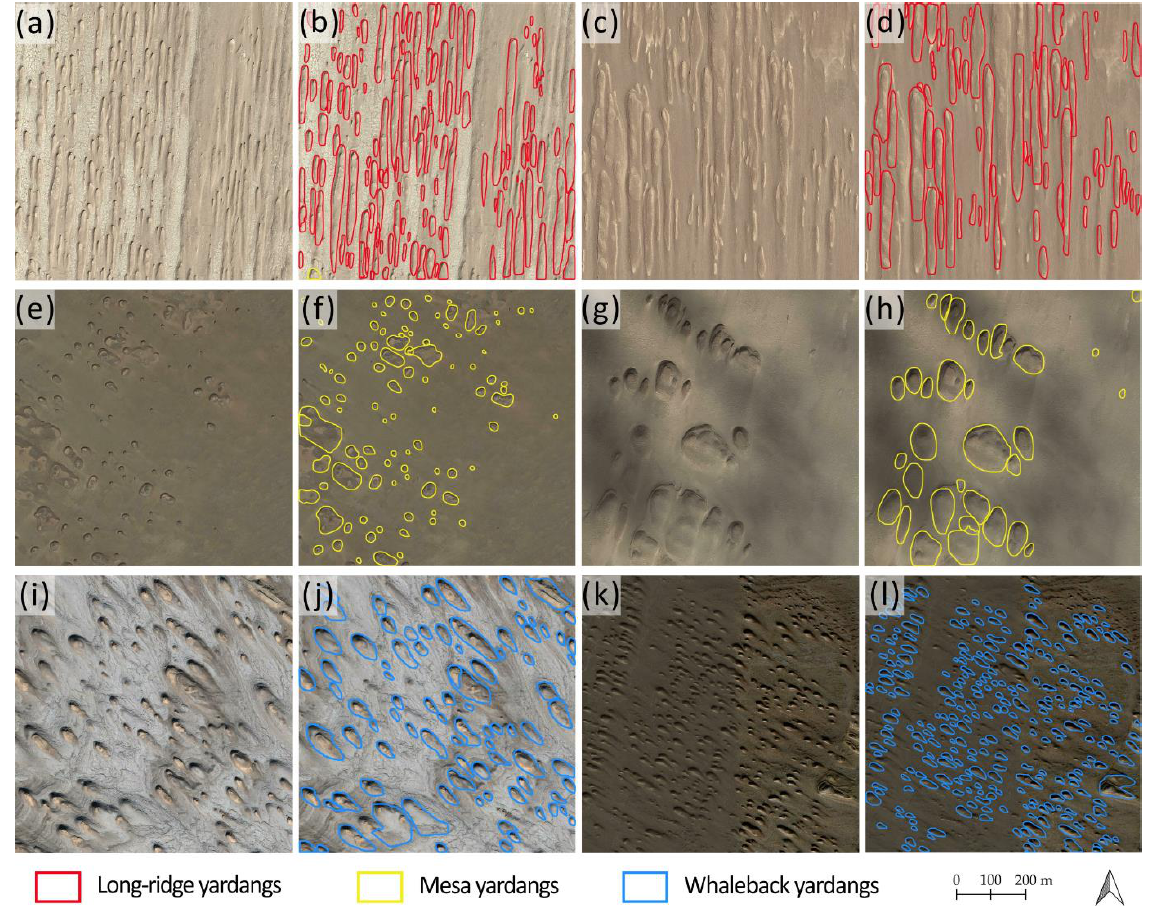
Figure 5. Examples of delineation and classification results on 0.6 m images. (a,c,e,g,i,k): enlarged 0.6 m spatial resolution images with their locations marked in Figure 2. (b,d,f,h,j,l): corresponding characterization results by Mask R-CNN where long-ridge, mesa and whaleback yardangs are depicted using polygons with red, yellow and blue borders, respectively. Table 3. Accuracy assessment for original images (1.2